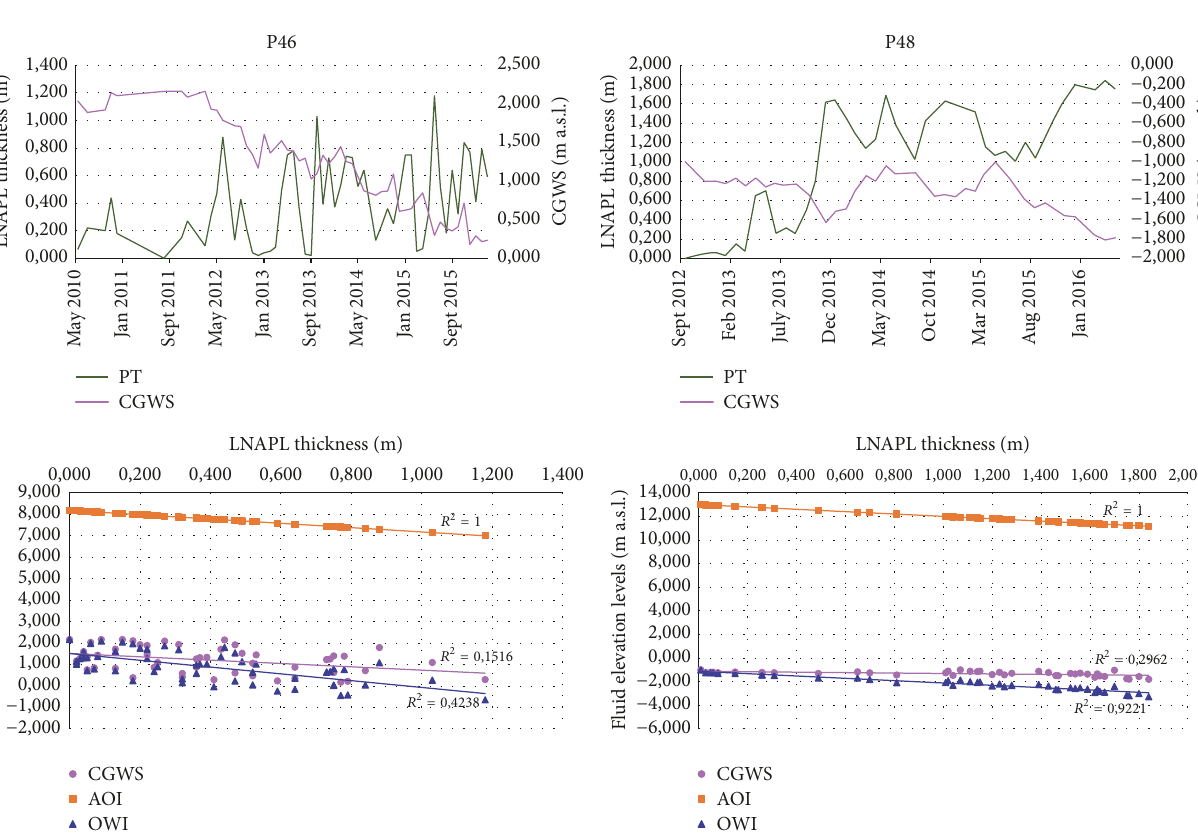
Figure 4: Hydrographs and diagnostic gauge plots of P46 and P48, indicating the product thickness (PT), the corrected water table level (CGWS), the air/oil interface (AOI), and the oil/water interface